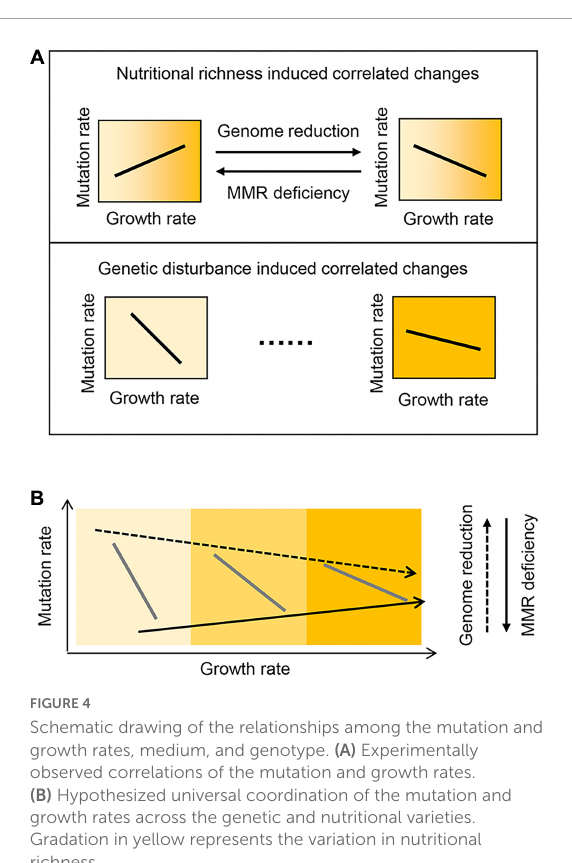
FIGURE4 Schematic drawing of the relationships among the mutation and growth rates, medium, and genotype. (A) Experimentally observed correlations of the mutation and growth rates. (B) Hypothesized universal coordination of the mutation and growth rates across the genetic and nutritional varieties. Gradation in yellow represents the variation in nutritional